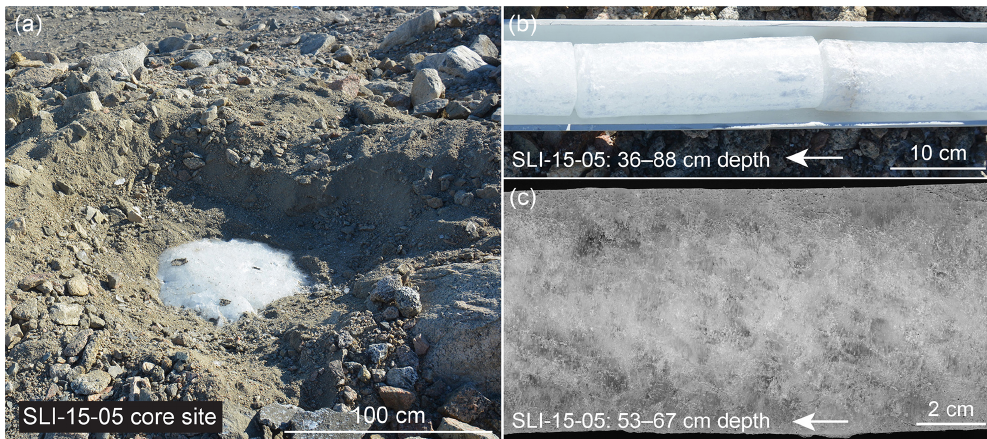
Figure 4. Buried ice core SLI-15-05. (a) Excavation of ∼ 30cm of sand- and boulder-rich sediments above buried ice, exposing sharp contact between sediments and ice surface. (b) Buried ice core pictured in the field, 36–88cm depth below ice surface; up-core is to the left (shown with arrow). (c) Buried ice core (53–67cm depth) after being cut vertically at NICL. At this depth, buried ice contained many gas inclusions and no